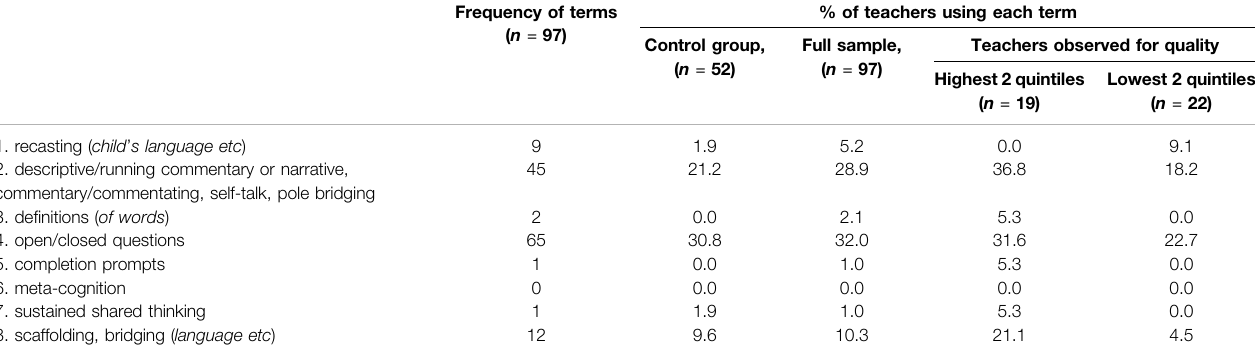
( Table 3 ) across an average of 19 responses, with rates marginally lower in the control group than the full sample. Slightly under half provided no interpretations at all. Among teachers who provided at least one interpretation, the mean number reported was slightly over three (control group (cid:1) 3.1, full sample (cid:1)